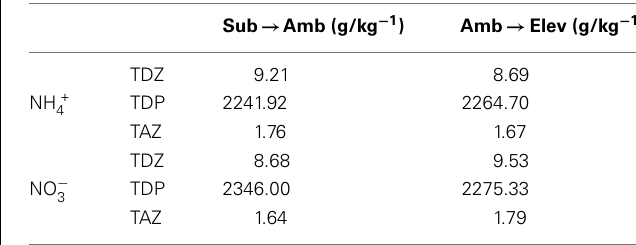
Table 3 |Total dietary Zn (TDZ), total dietary phytate (TDP), and total bioavailable Zn (TAZ) of a human population from a hypothetic less developed nation reliant on wheat for 50% of their dietary